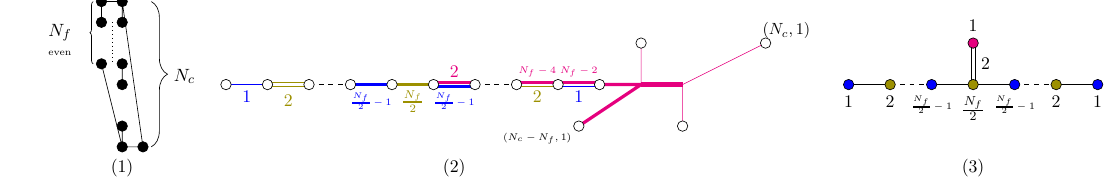
Figure 8 . (1) Toric Diagram representing SQCD with N f N c and N f even at finite gauge coupling where masses are set to zero. (2) Brane Web ≤ indicating the mesonic branch of the Higgs Branch (3) magnetic Quiver whose 3d Coulomb Branch is the mesonic branch of the Higgs Branch of our SQCD. For N f < N c the Higgs branch consists only of the mesonic